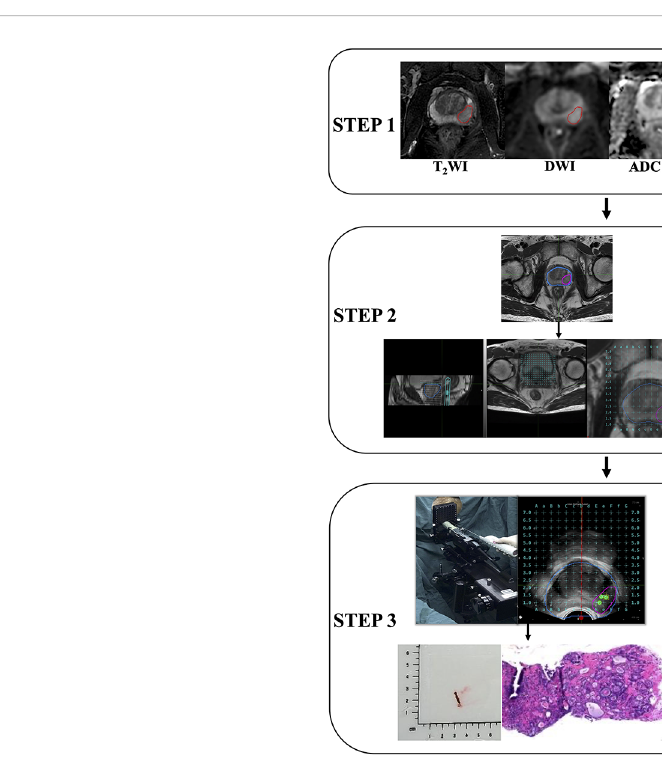
FIGURE 3 Acquisition pathology of target lesion by magnetic resonance imaging-Transrectal ultrasound (MRI-TRUS) fusion biopsy (BK Medical,